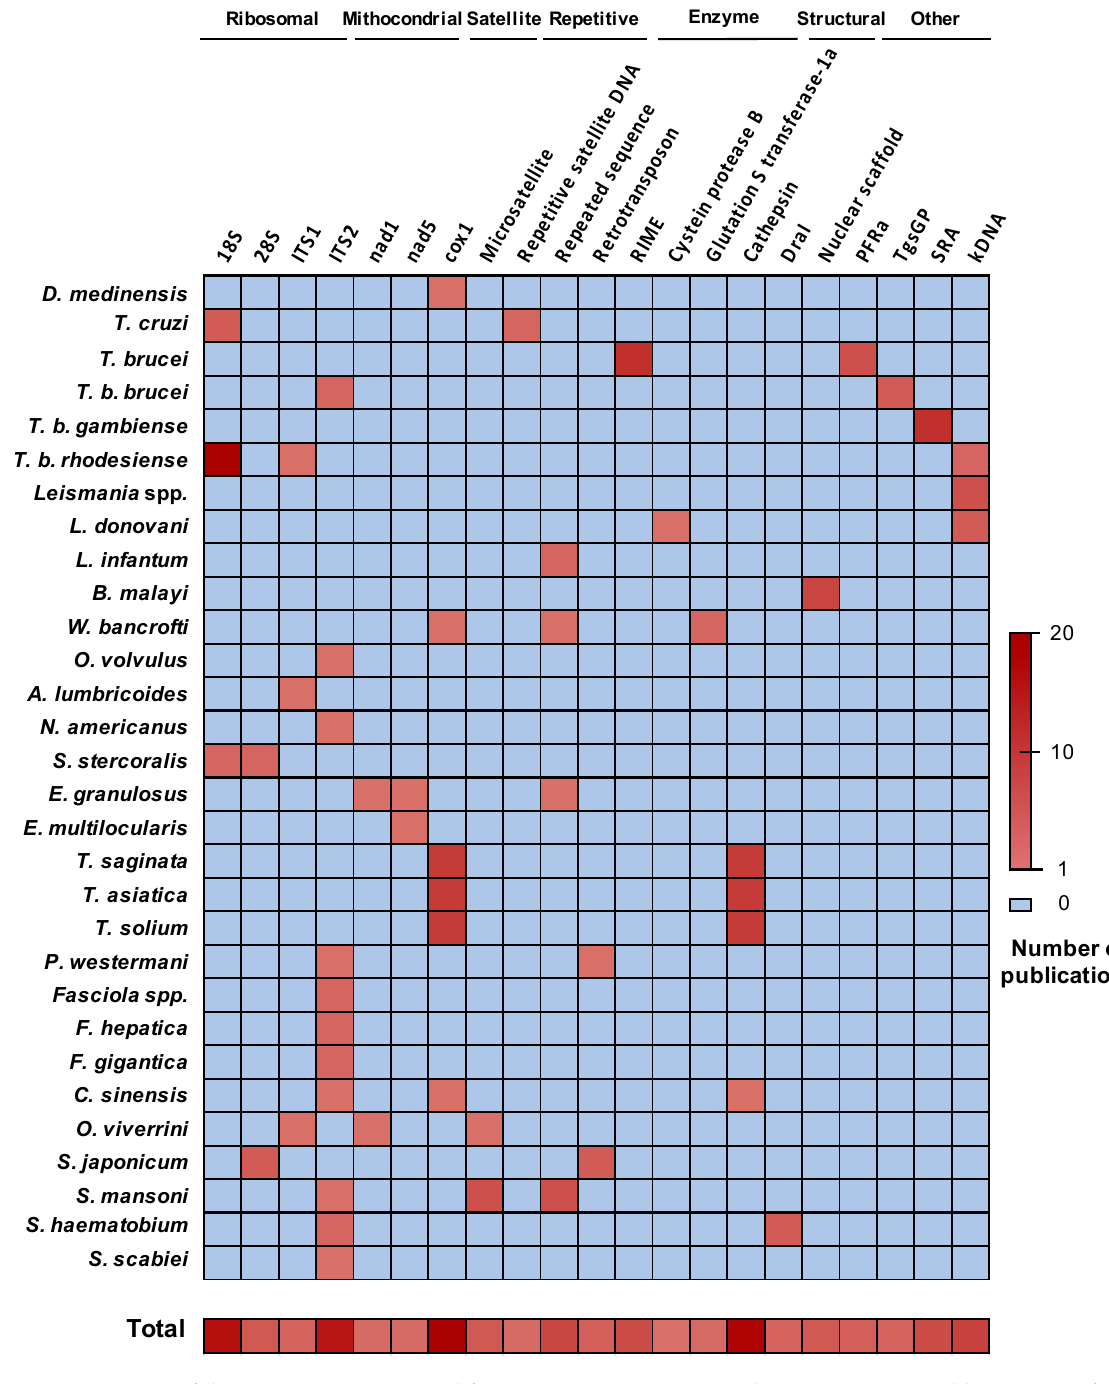
Figure 4. Heat map of the target sequences used for LAMP in parasite-caused NTDs. Sequence abbreviations, from left to right: Microsat (Microsatellite), Rep sat (Repetitive Satellite), Rep Seq (Repetitive sequence), Retrotrans (Retrotransposon), RIME (Repetitive insertion mobile element), CpB (Cystein protease B), GST1a (Glutation-S-Transferase 1a), Nucl scaffold (Nuclear scaffold); PFRa (Paraflagellar Rod) TgsGP ( T. b. gambiense specific gene,) SRA (serum-resistance associated gene) kDNA (kinetoplast DNA). Data obtained from all the publications used in this review.